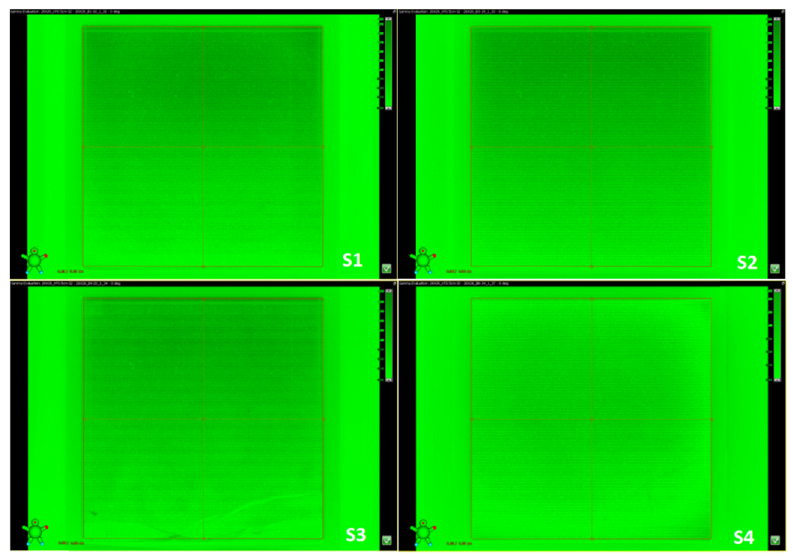
Figure 5: Blended view of gamma analysis results of the 0.5 cm thick bolus samples and R0.5 for 1%/1 mm criteria ( from upper left to right S1, S2, S3 and S4, respectively ) .